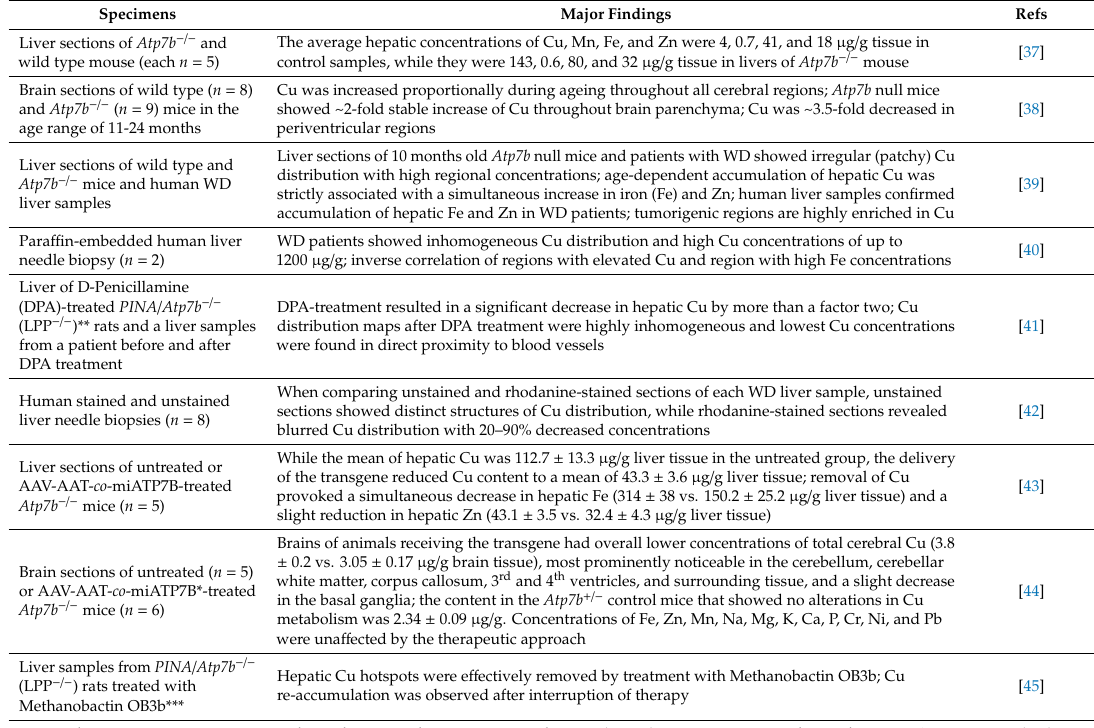
Table 1. Studies using LA-ICP-MSI in experimental or clinical Wilson disease